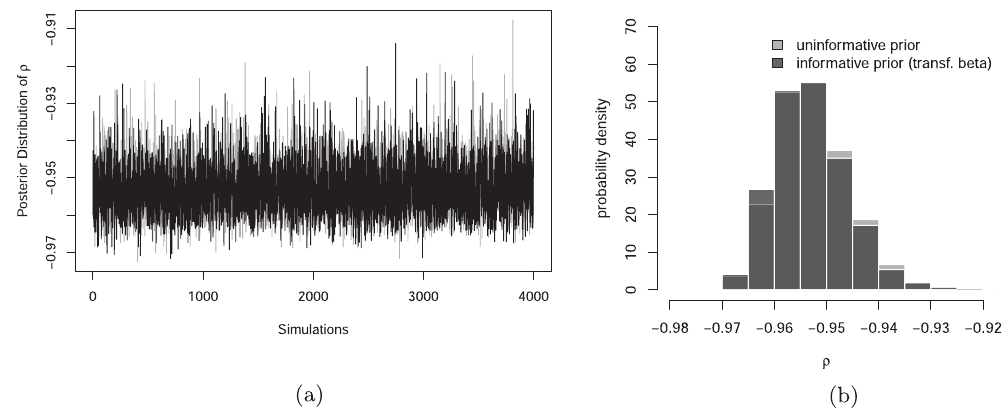
Figure 4. Convergence diagnostics of the HMC simulations – Gaussian Copula. (a) Trace plot of simulations. (b) Effect of the prior